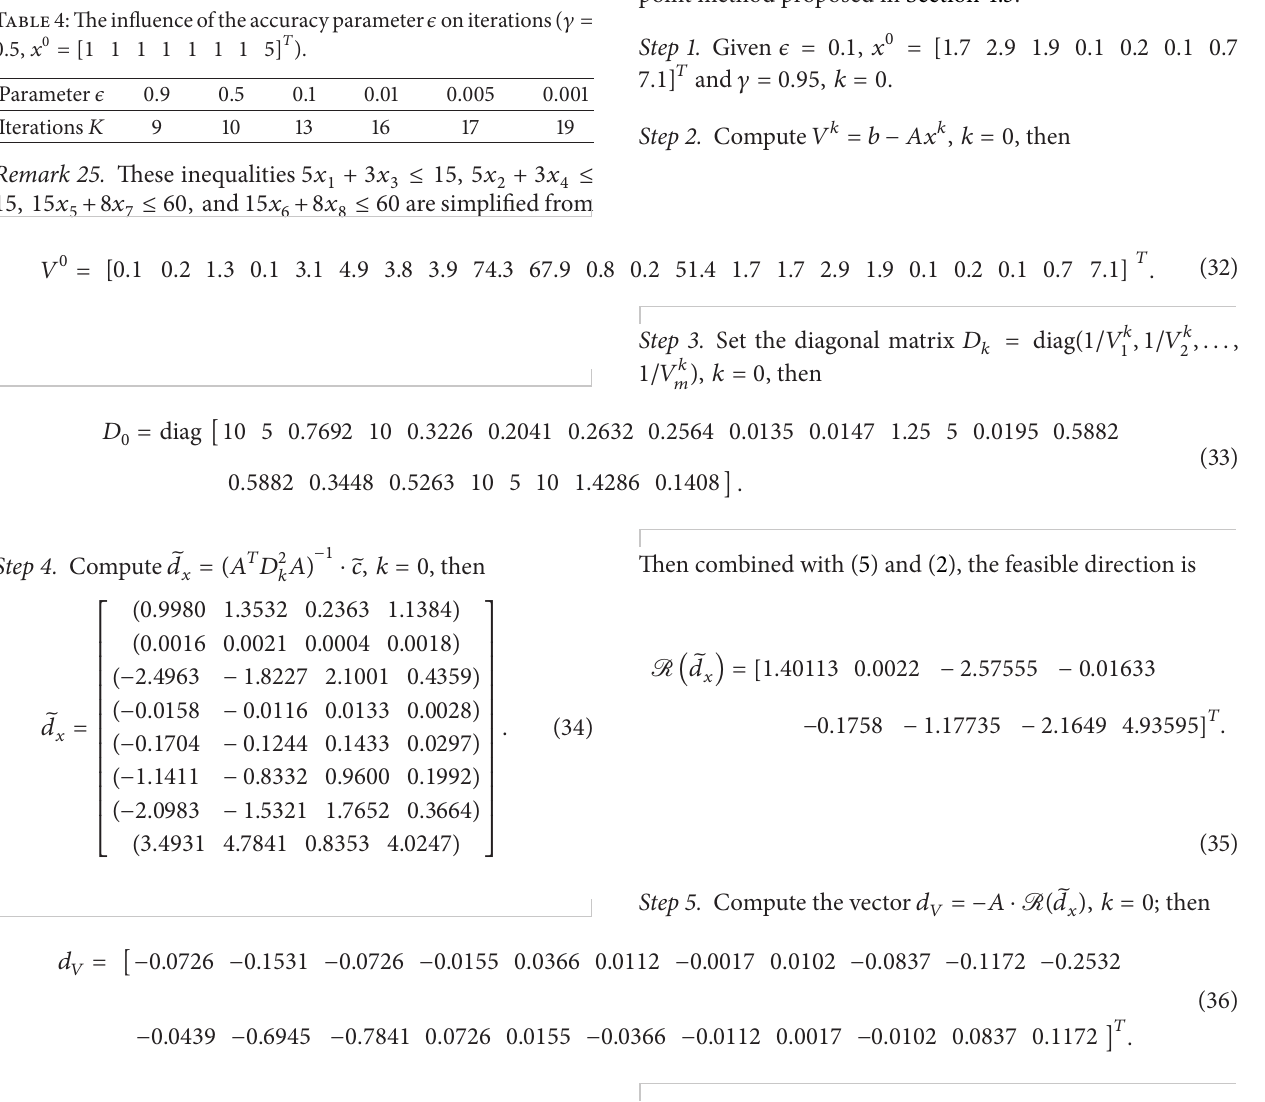
Table4:Theinfluenceoftheaccuracyparameter 𝜖 oniterations (𝛾